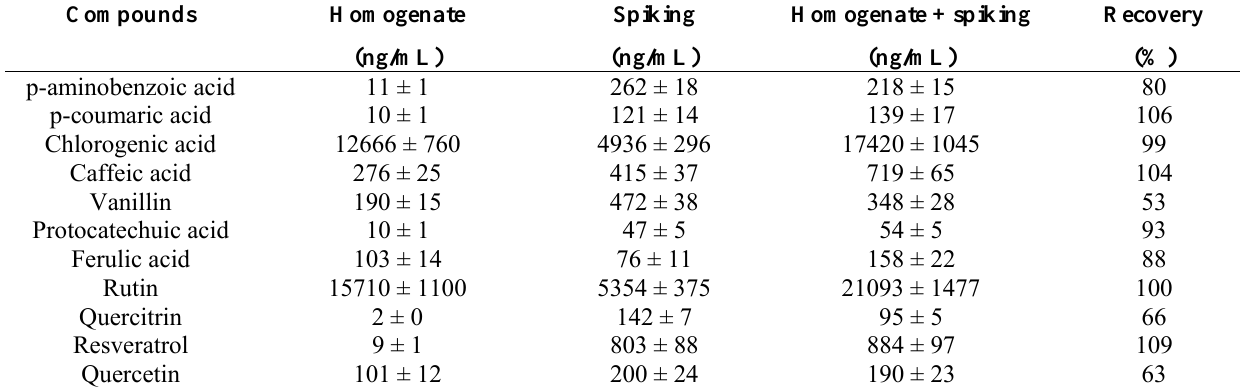
Table 7. Maceration 4